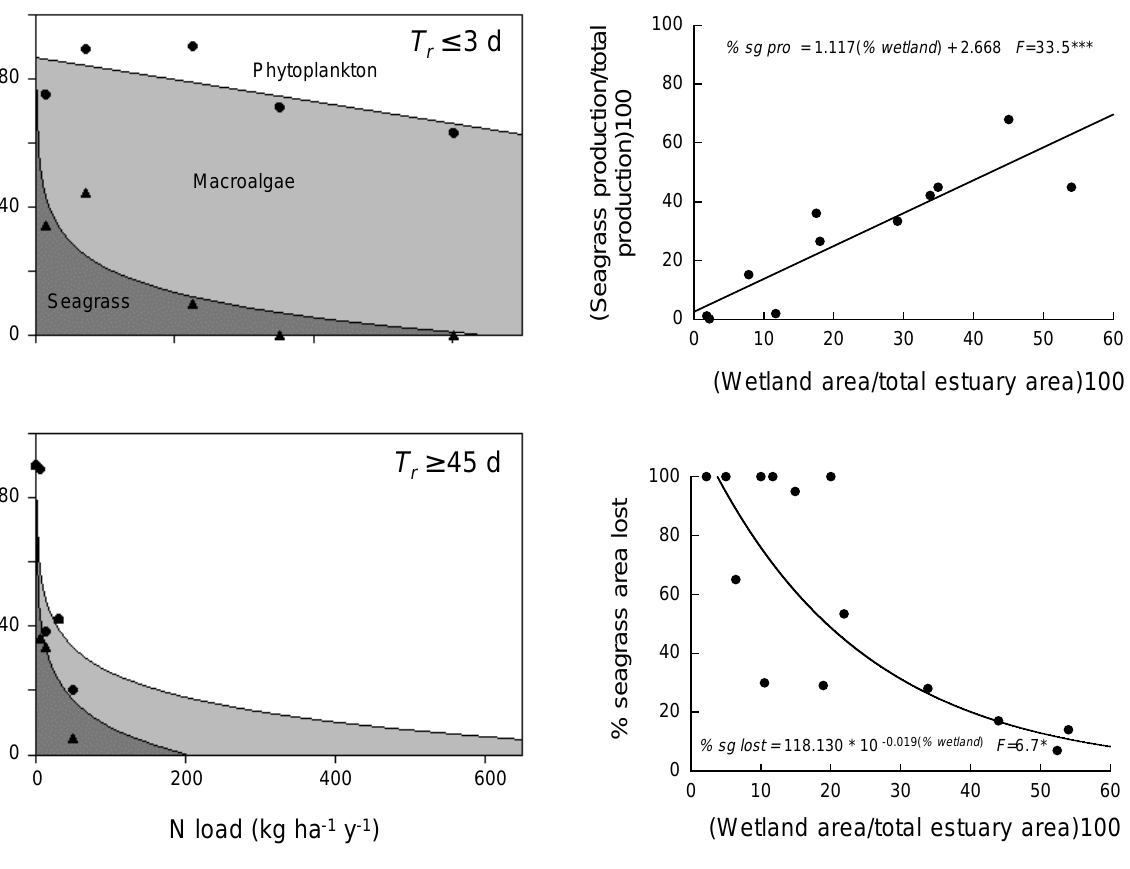
F IG . 8. – Top: Seagrass production expressed as a % of total pro- F IG . 7. – Proportion of primary production by phytoplankton, duction in many estuaries, plotted versus the area of fringing wet- macroalgae, and seagrasses in estuaries subject to different land- land expressed as a % of total estuary area. Bottom: % of area of derived nitrogen loads. Top panel contains information for estuaries seagrass habitat lost (over last 10 to 30 years) plotted versus the % whose water residence times ( T ) are less than 3 d, bottom panel for r of area of the estuary made up by fringing wetland. From Valiela estuaries with T greater than 45 d. From Valiela et al. r and Cole (in press).